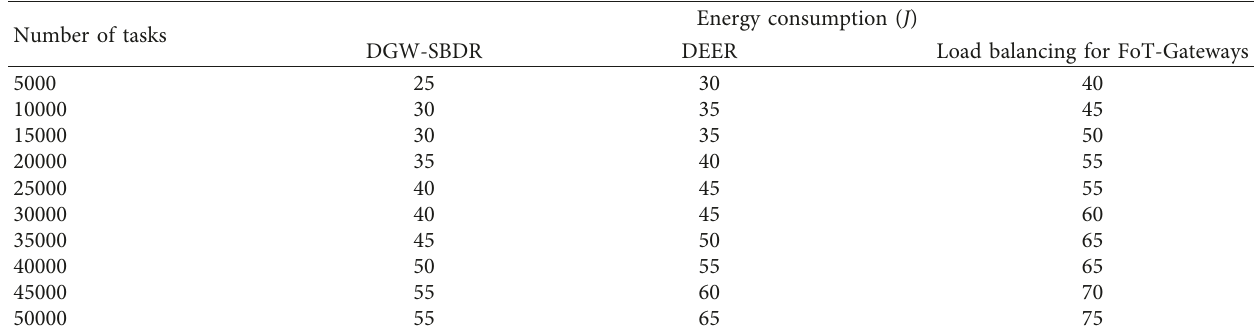
Table 6: Simulation results for energy